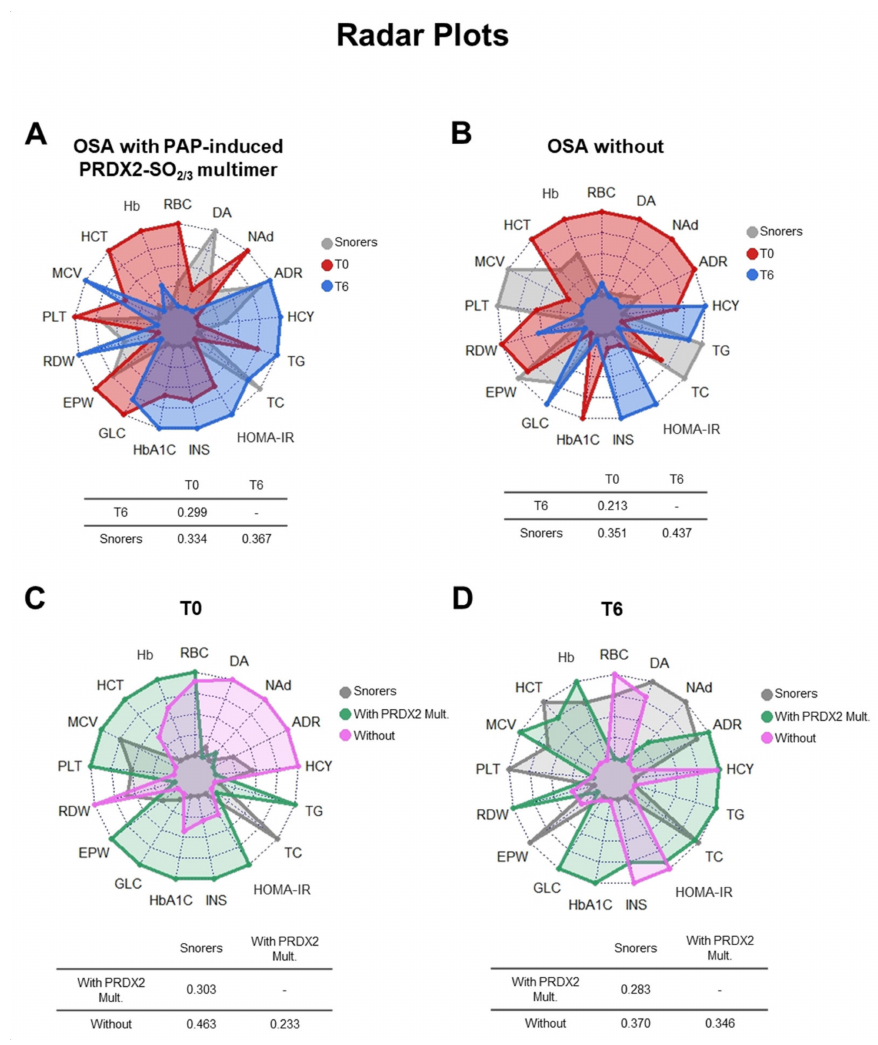
Figure 6. The study clinical parameters are displayed in one dimension comparing the OSA subgroup with ( A ) or without PAP-induced PRDX2-SO 2 / 3 response ( B ), measured at time t0 (T0, red) and t6 (T6, blue) with the Snorer group as a control reference (gray); or OSA subgroup with (green) and without PAP-induced PRDX2-SO 2 / 3 response (rose) at t0 ( C ) and t6 ( D ) with the Snorer group as a control reference (gray). Each clinical parameter is represented on a di ff erent radius of a radar plot. The centroid points in the periphery represented the highest average value, whereas the centroid points in proximity to the center corresponded to the lowest average value for a clinical parameter. The similarities between the di ff erent groups at di ff erent conditions are measured by the Gower similarity measure (the closer to 1, the more similar the groups) and the results indicated at the bottom to each corresponding radar